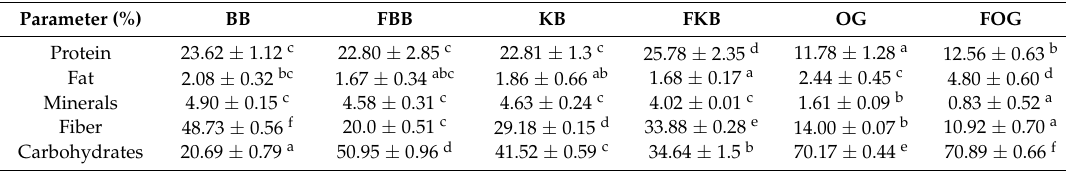
Table 1. Nutritional components of different obtained flours.